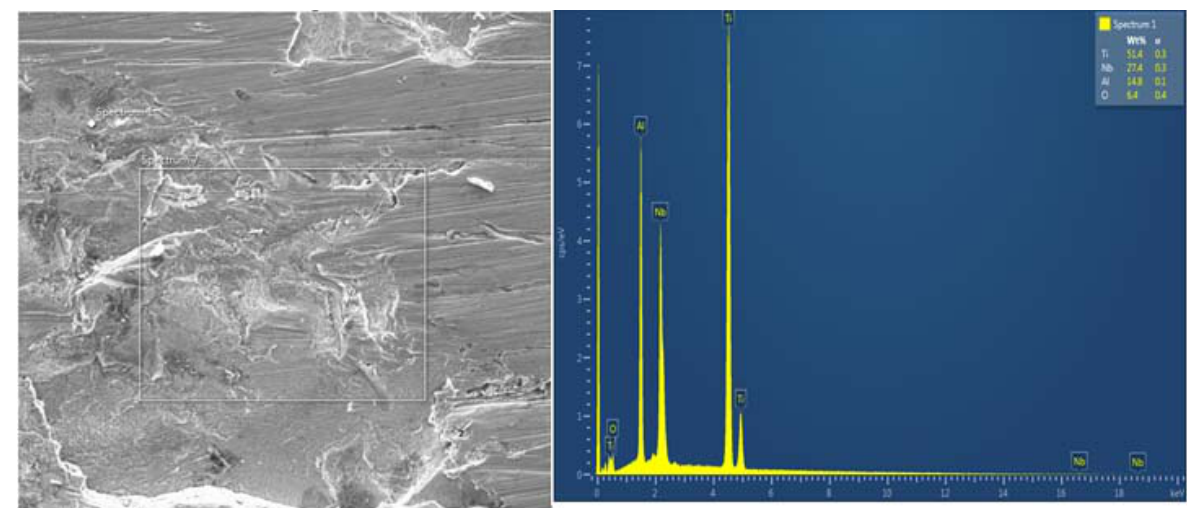
Figure 8. SEM/EDS of corroded sample in 3.65%